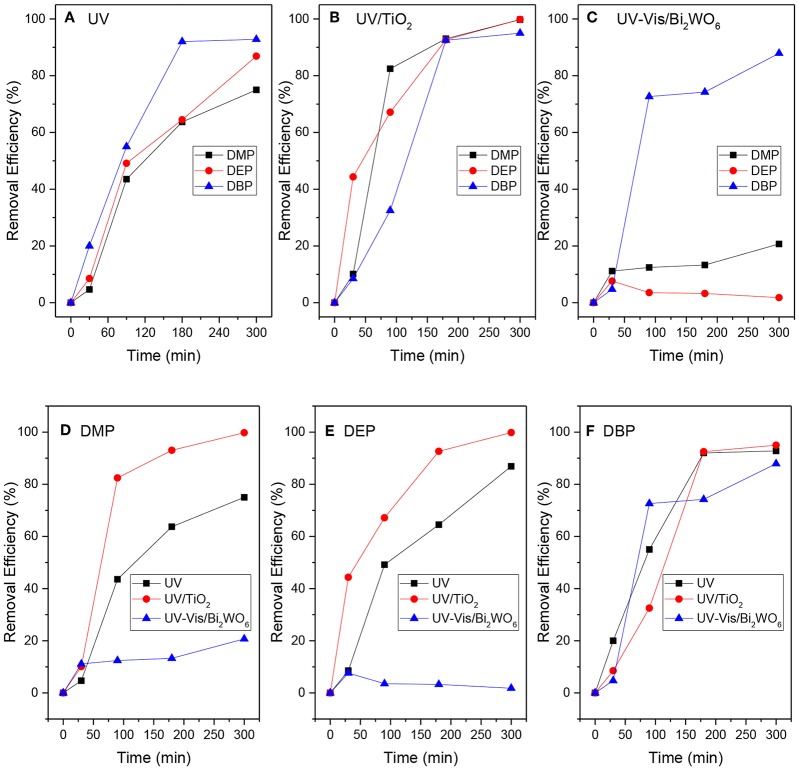
The removal of DMP, DEP, and DBP in different degradation systems (A: PAEs in the UV system; B: PAEs in the UV/TiO2 system; C: PAEs in the UV-Vis/Bi2WO6 system; D: DMP in the three systems; E: DEP in the three systems; F: DBP in the three systems).